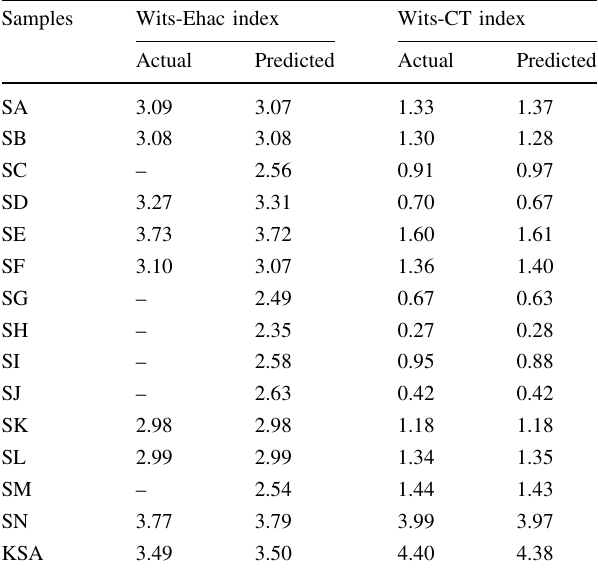
Table 10 Actual and predicted Wits-Ehac and Wits-CT index for coal-shales